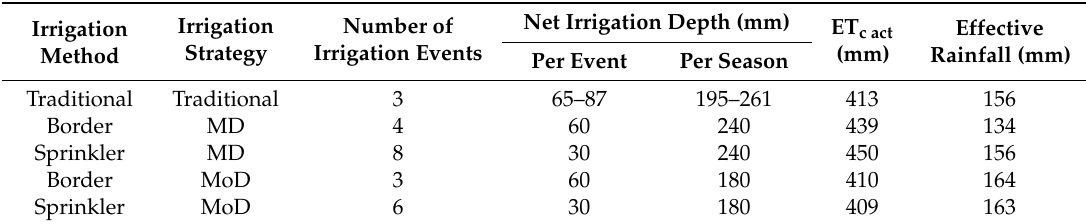
Table 2. Wheat irrigation scheduling for surface and sprinkler systems at Ras-El-Ain considering mild (MD) and moderate-deficit (MoD) irrigation.